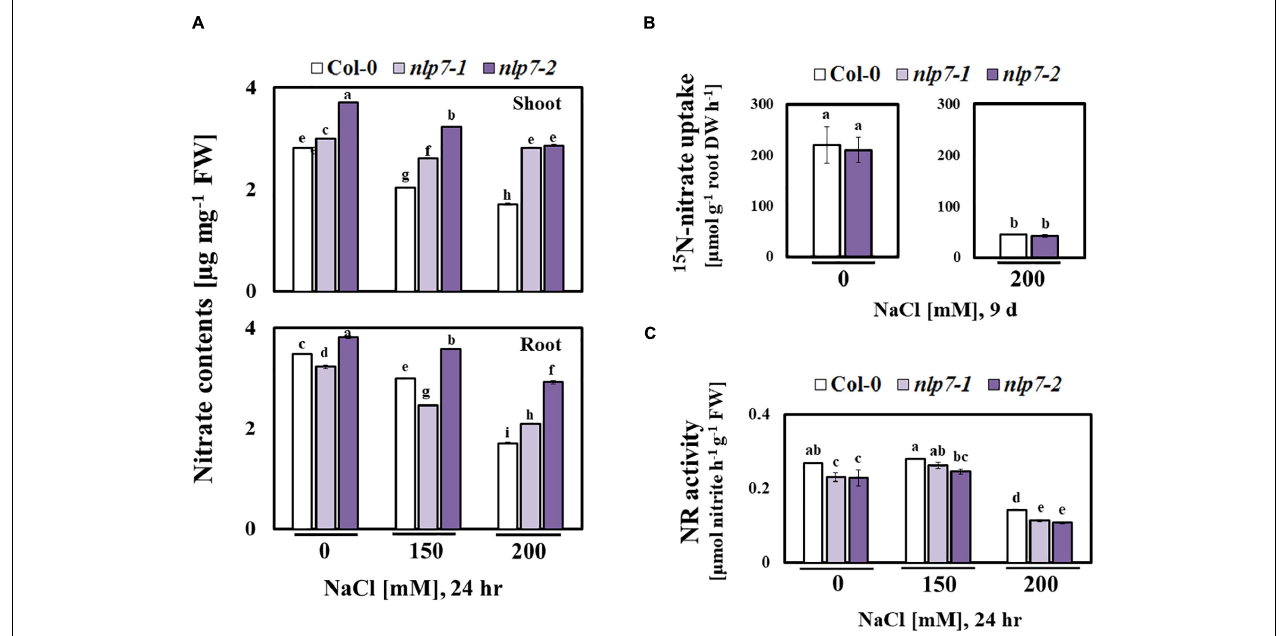
FIGURE 4 | Nitrate content was elevated, and nitrate reductase activity was altered in nlp7 mutants under salt stress. (A) The nitrate content of the shoots and the roots of 9-day-old Col-0, nlp7-1 , and nlp7-2 seedlings was measured. The seeds were germinated and grown on nitrogen-free half-strength MS medium containing 5 mM KNO 3 for 9 days and then treated with 0, 150, and 200 mM NaCl for 24 h. Error bars represent the standard deviation of three independent replicates. (B) 15 NO 3 uptake in the roots of Col-0 and nlp7-2 seedlings. The seedlings were germinated and grown on a nitrogen-free half-strength MS medium with or without 200 mM NaCl for 9 days and then transferred to a medium containing 20 mM of 15 NO 3 – and kept for 1 h. Error bars represent the standard deviation of three independentreplicates. (C) Comparison of nitrate reductase activity under salt stress between 9-day-old Col-0 and nlp7 seedlings. Error bars represent the standard deviation of three independent replicates. Different letters (a, b, c, d, e, f, g, h, or i) within a treatment group indicate significant differences in the two-way ANOVA ( P ≤ 0.05, Tukey’s